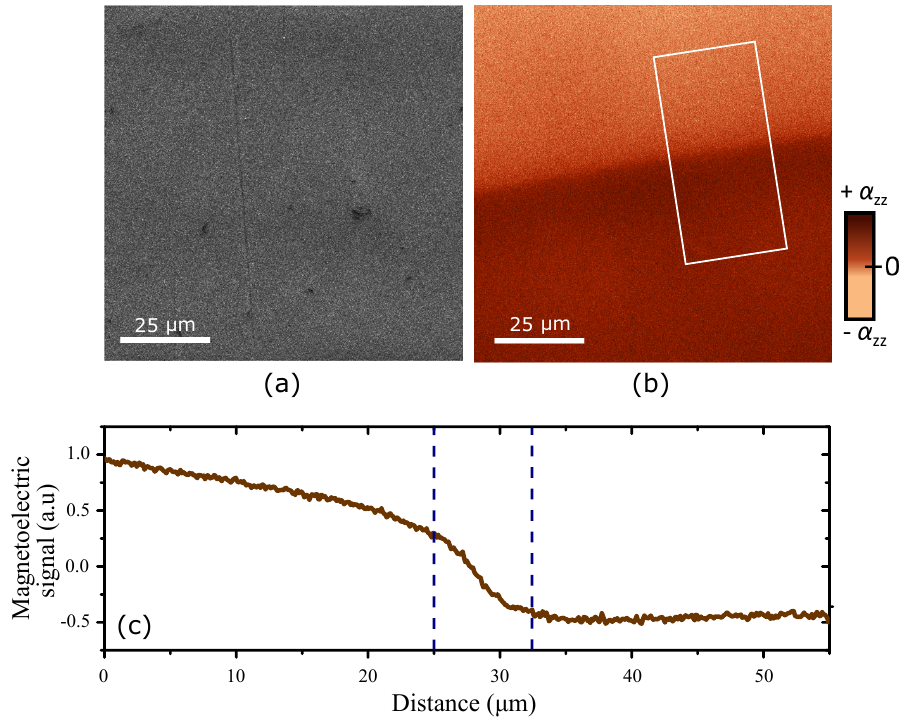
Figure 3. MeFM scans at 263K on an area of 100 × 100 µ m 2 of a z -oriented Cr 2 O 3 sample as in Figure 2. ( a ) First pass—topography; ( b ) Second pass—magnetoelectric signal. The antiferromagnetic domain wall is only visible in the magnetoelectric scan; ( c ) Cross-section of the region at the domain wall as outlined in panel ( b ). The markers in ( c ) indicate a width of the wall region of about 7.5 µ m which is a convolution effect caused by the tilted propagation of the wall away from the surface (see Section